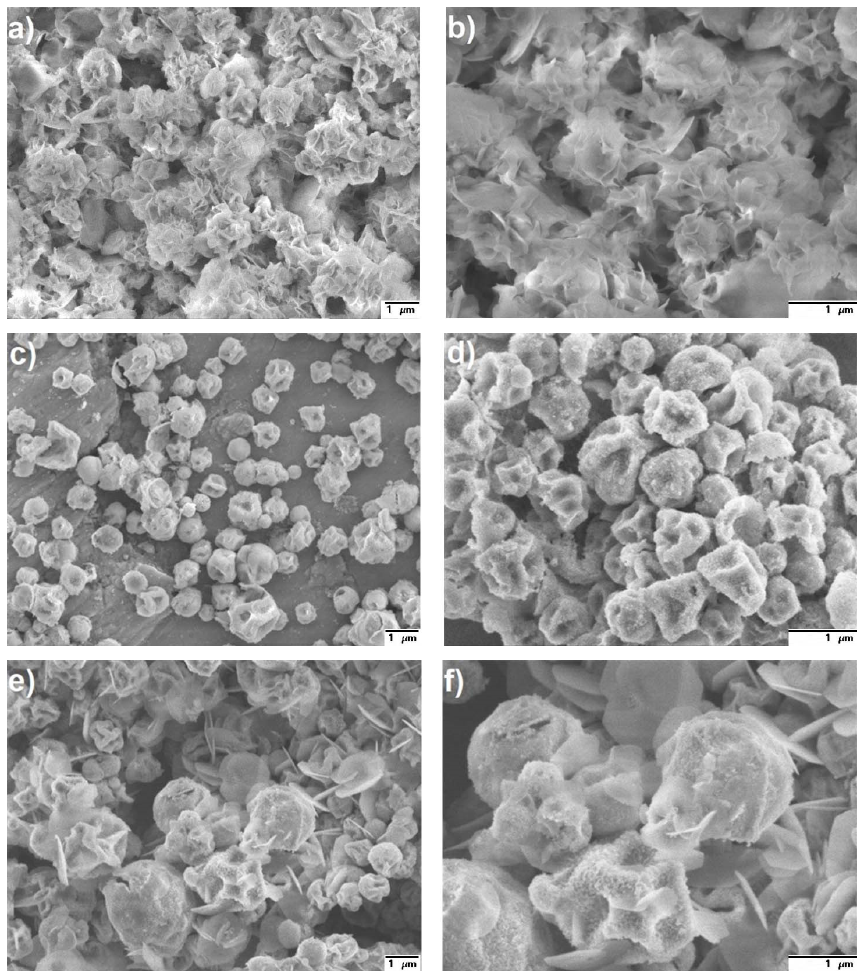
Figure 5. SEM results of the NiO/ZnO/Al 2 O 3 particles: ( a ) ×10,000; ( b ) ×20,000 magnification for the samples of 400 °C; ( c ) ×10,000; ( d ) ×20,000 magnification for the samples of 600 °C; ( e ) ×10,000; ( f ) ×20,000 magnification for the samples of 800 °C.